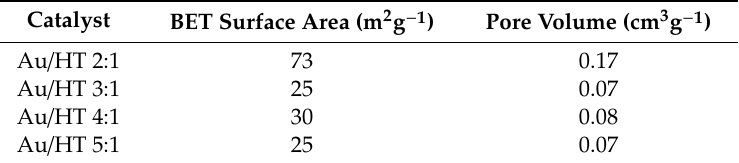
Table 2. Textural properties.